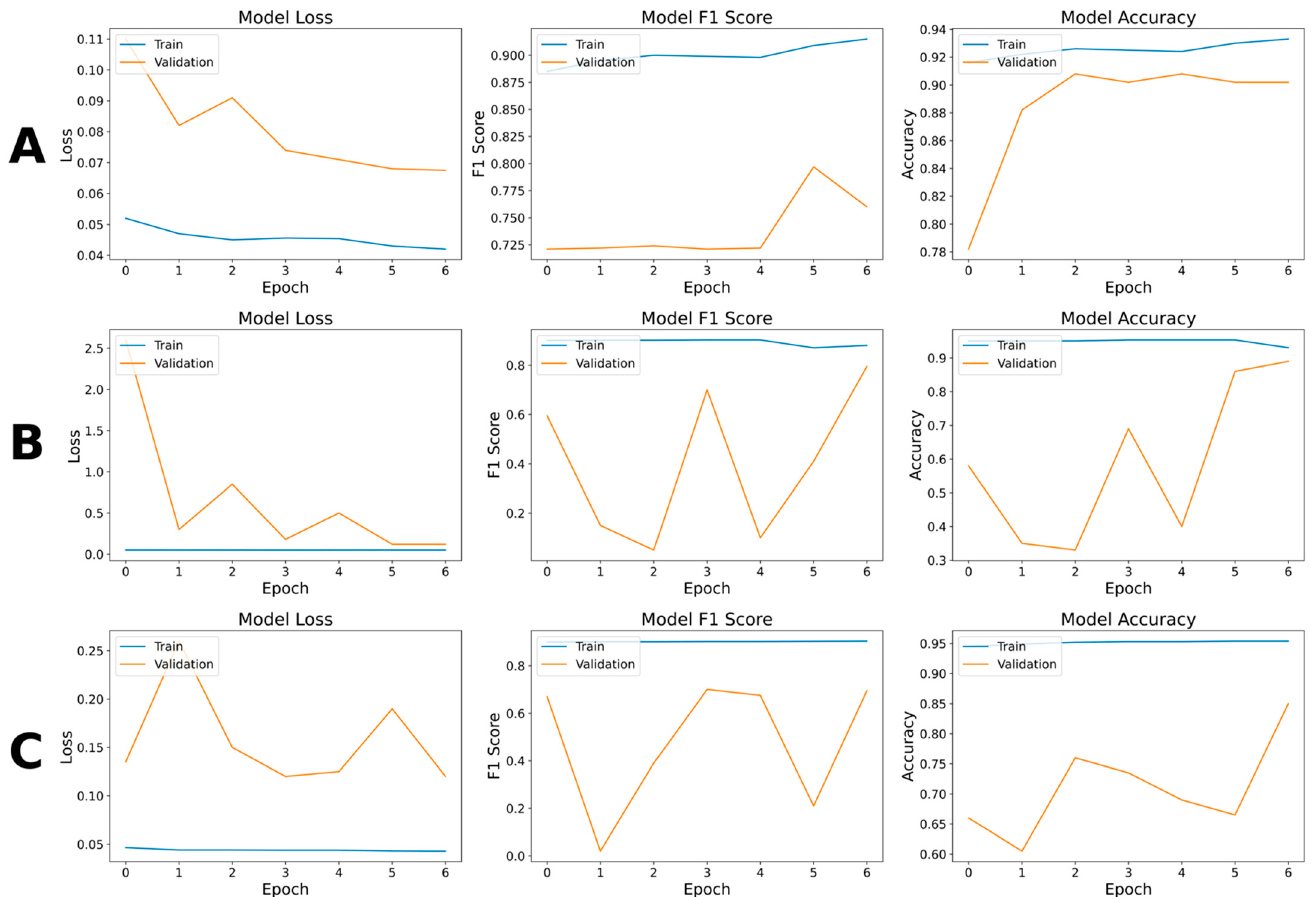
Figure 3. Metrics of the three best-performing models produced. ( A ) U-Net, ( B ) VGG19, and ( C ) ResNet50 models.